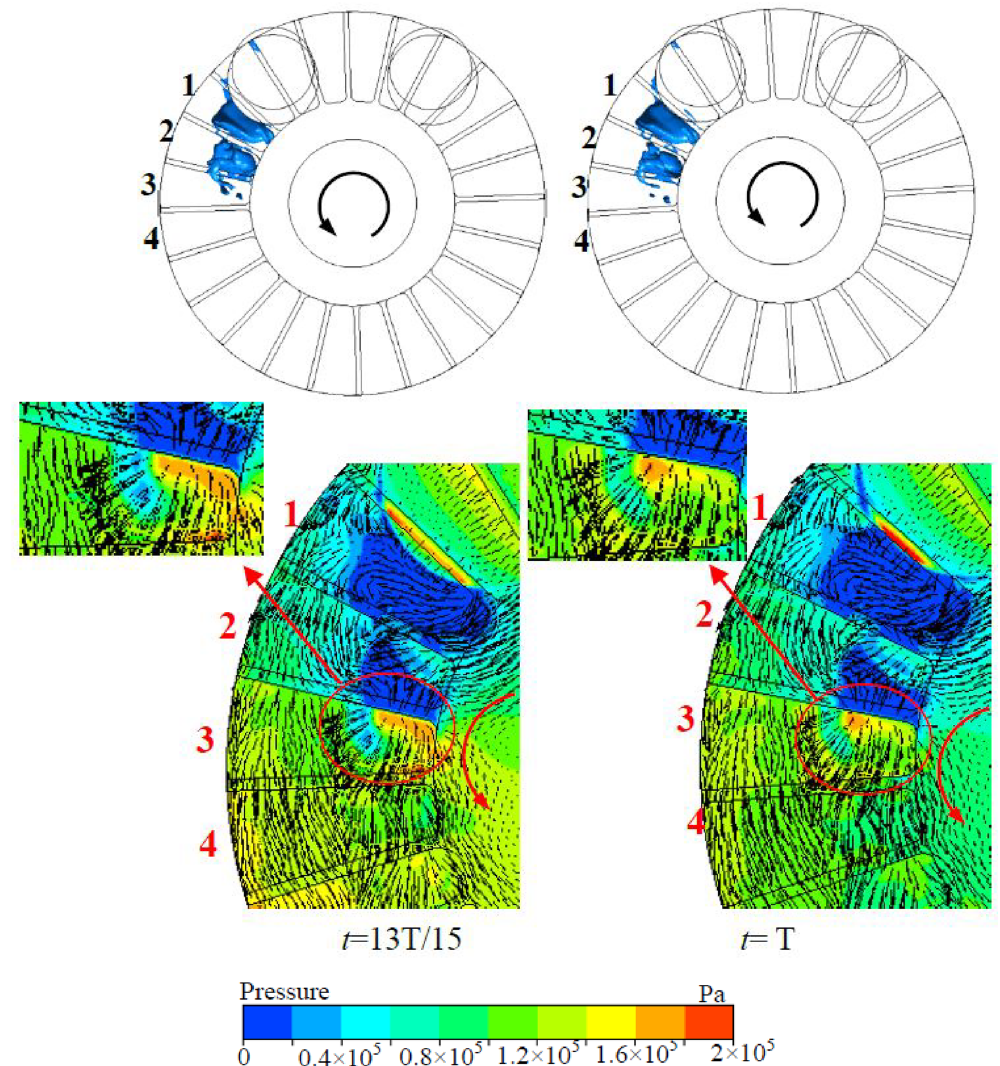
Figure 7 Evolution of vapors with impeller rotation and pressure contour with velocity vector at NPSHa